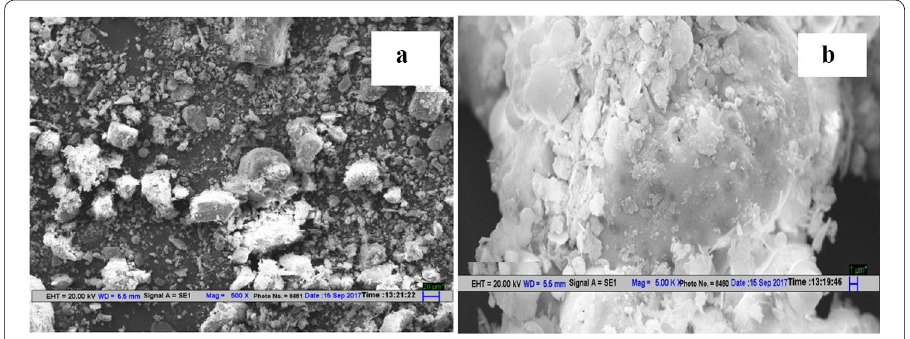
Fig. 11 SEM image of specimen 20CBA ( a ) at